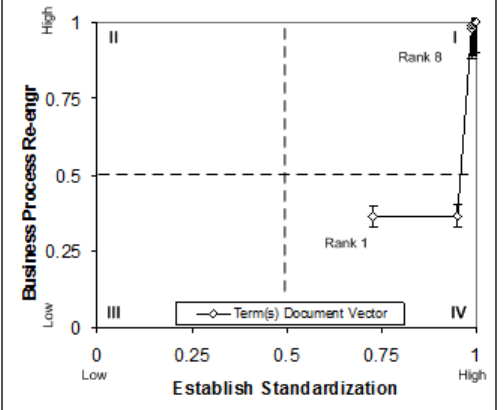
Figure 7. Toyota’s thinking for achieving work outcomes